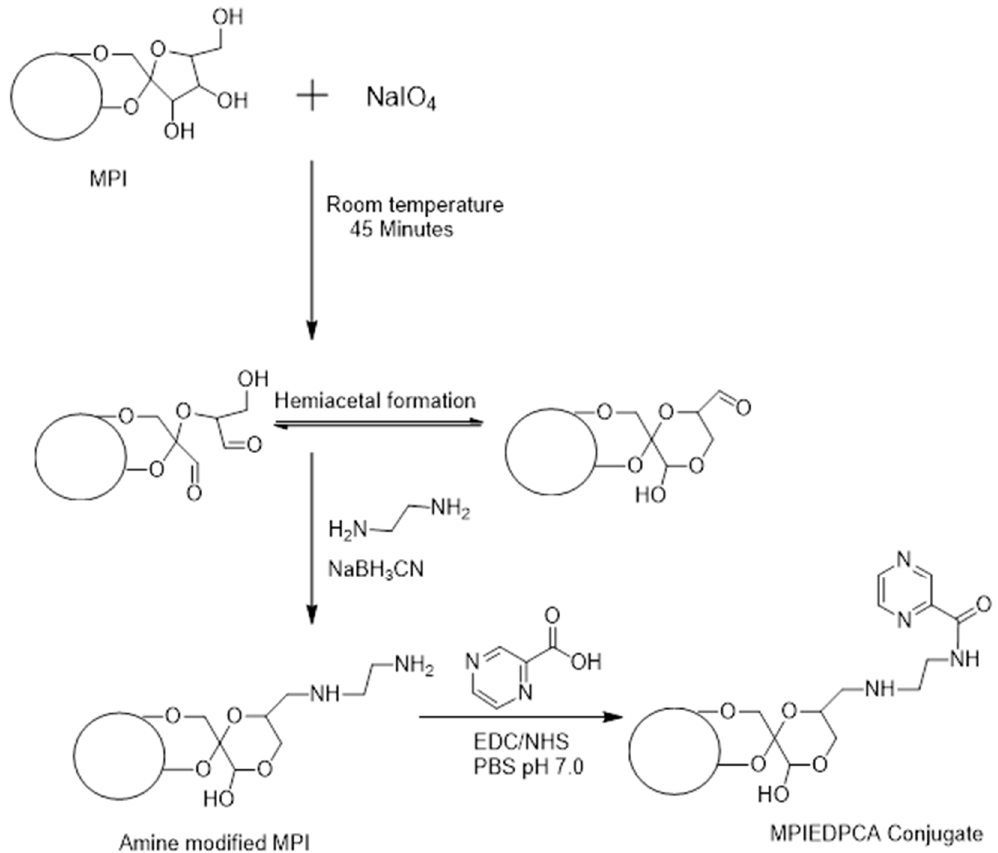
Figure 2. Synthesis of MPI conjugate.